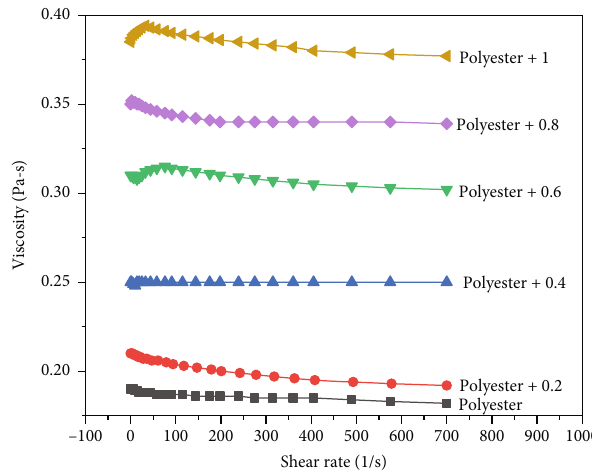
Figure 9: Complex viscosity of MWCNT nanocomposites. Figure 10: Volumetric speci fi c heat of MWCNT